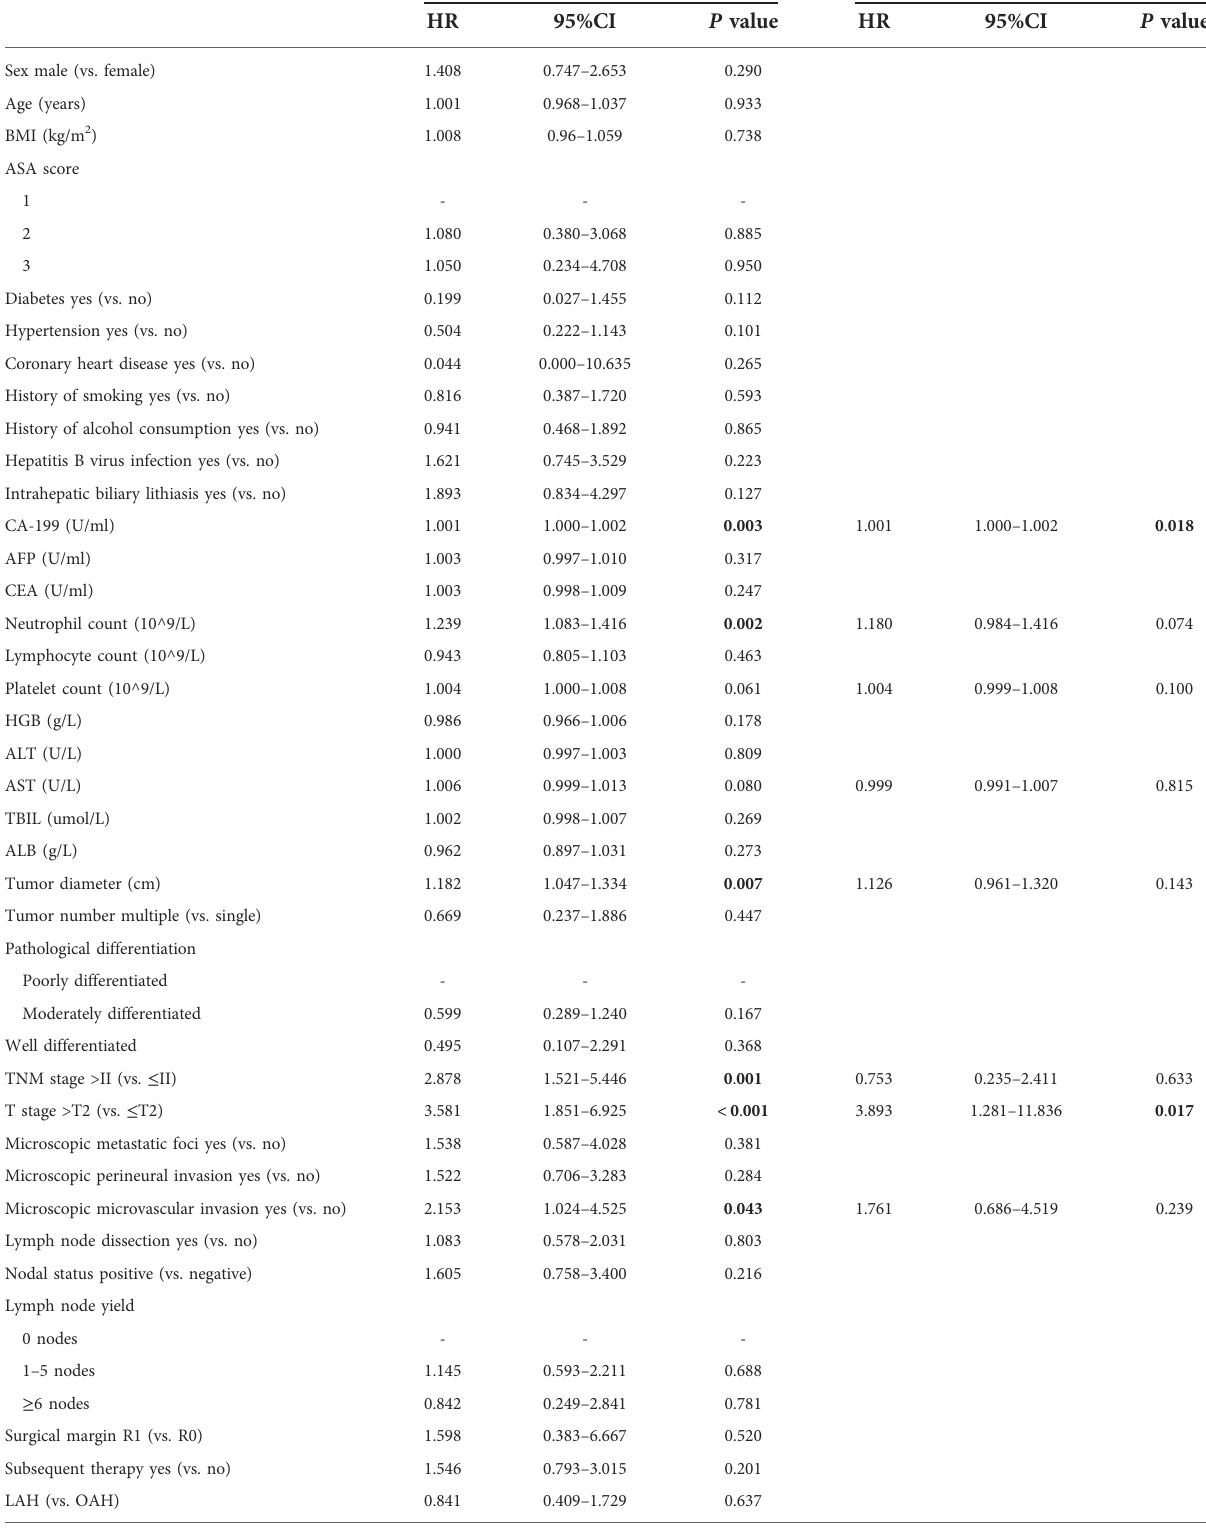
TABLE 5 Univariate and multivariate analyses of factors associated with disease-free survival